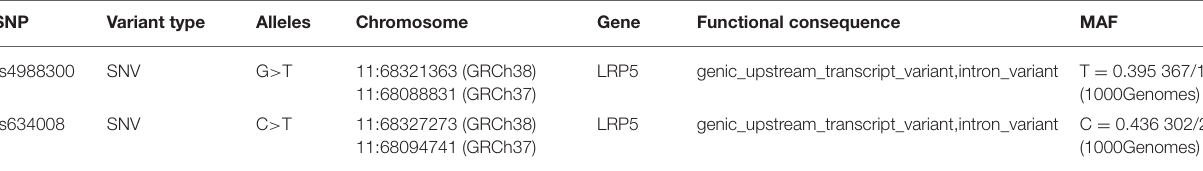
TABLE 1 | Basic information of the study SNPs.